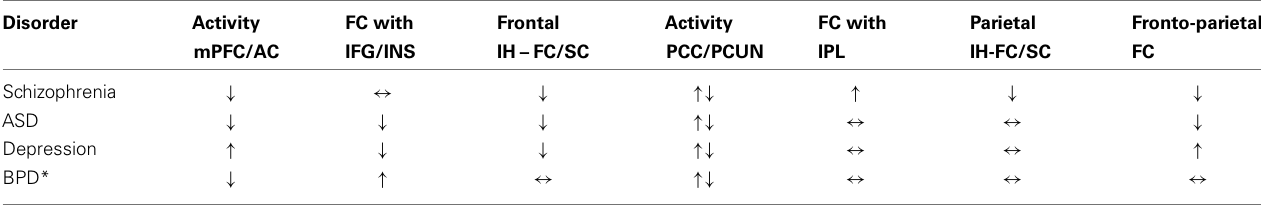
Table 1 | Overall activity and functional connectivity changes in frontal and parietal cortical midline system regions involved in self-processing in schizophrenia,ASD, depression, and